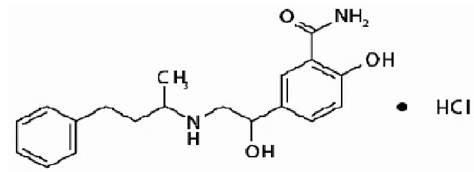
Fig. 1. Chemical structure of labetalol